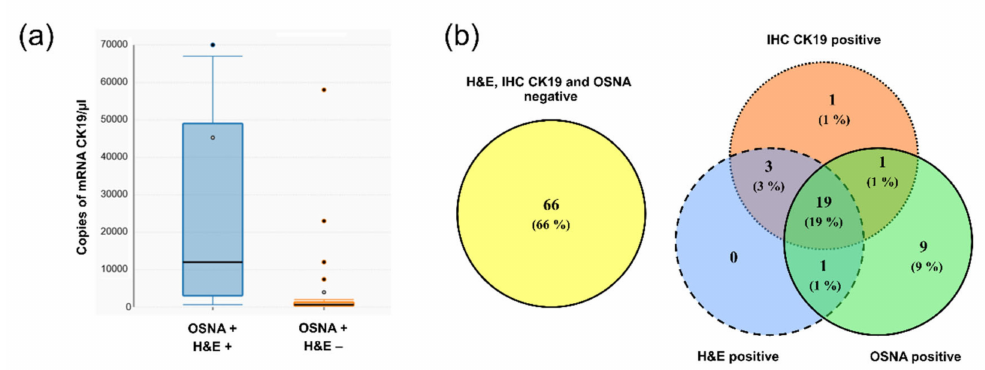
Figure 4. Data supporting new cut-o ff value. ( a ) Box plots showing copy number of mRNA CK19. Groups of lymph nodes, positive based on both OSNA and H&E methods (OSNA + H&E + ), have significantly higher copies of mRNA CK19 than those positive by the OSNA method but negative by H&E (OSNA + H&E − ); ( b ) comparison of examination results of patients for the presence of tumor cells using the H&E, IHC CK19 and OSNA methods by Venn diagrams using the new cut-o ff value of the OSNA method 615 copies of mRNA CK19 / µ